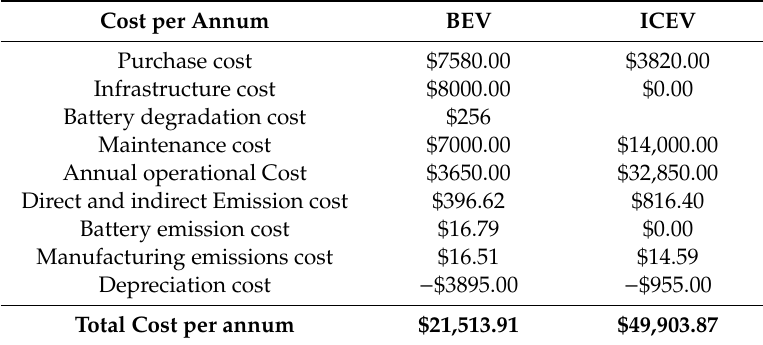
Table 9. The annual cost–benefit analysis of BEV and